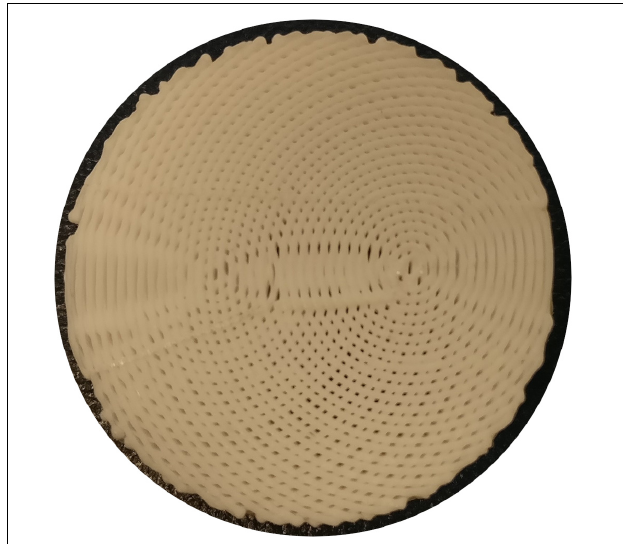
FIGURE 2 | Photograph of an early 3AM phantom with the fanning pattern (absent from this photograph is the triangular gap used as a fiducial in the final fanning